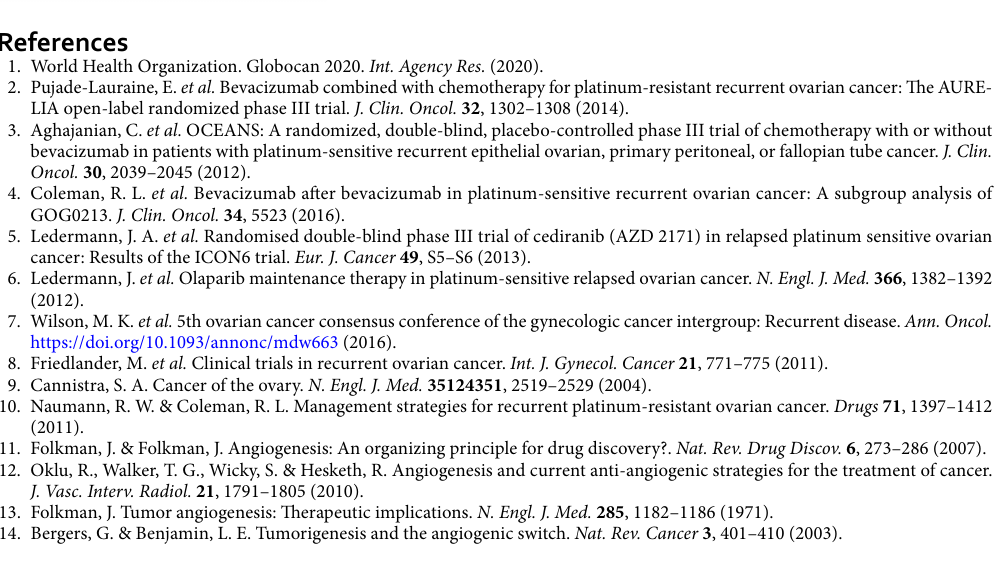
Figure 5. ( a ) Network plot of comparisons among different anti-angiogenic agents and standard of care chemotherapy for overall survival in the platinum-sensitive setting. Key for ( a ): Bev_C Bevacizumab (concurrent), Bev_CM Bevacizumab (concurrent + maintenance), Ced_CM Cediranib (concurrent + maintenance), Chemo Standard of care chemotherapy. Note for ( a ): Nodes represent the interventions, lines connecting nodes represent direct comparisons between pairs of interventions, the number stated on the lines represents the number of studies involved in the comparisons. ( b ) Comparative effectiveness of different anti-angiogenic agents and standard of care chemotherapy for overall survival in the platinum-sensitive setting. Key for ( b ): Bev_C Bevacizumab (concurrent), Bev_CM Bevacizumab (concurrent + maintenance), Ced_CM Cediranib (concurrent + maintenance); Chemo, Standard of care chemotherapy. Note for ( b ): The upper triangle of the matrix displays only the pooled effect sizes of the direct comparisons available in the network. Fields that remain empty in the upper triangle mean that the direct evidence for the comparison is not available. The lower triangle shows the estimated effect sizes for each comparison even when only indirect evidence is available. In the lower triangle of the matrix, values in each cell represent the hazard ratio (HR and 95% confidence interval) of the intervention at the top, compared to the comparator on the left. When HR < 1, prefers the column intervention, indicating that the column intervention is more effective than the row intervention on reducing overall survival. When HR > 1, prefers the row intervention. Significant results are in bold and underlined for both upper and lower triangles. ( c ) Network plot of comparisons among different anti-angiogenic agents and standard of care chemotherapy for progression-free survival in the platinum-sensitive setting. Key for ( c ): Bev_C Bevacizumab (concurrent), Bev_CM Bevacizumab (concurrent + maintenance), Ced_CM Cediranib (concurrent + maintenance), Chemo Standard of care chemotherapy. Note for ( c ): Nodes represent the interventions, lines connecting nodes represent direct comparisons between pairs of interventions, the number stated on the lines represents the number of studies involved in the comparisons. ( d ) Comparative effectiveness of different anti-angiogenic agents and standard of care chemotherapy for progression-free survival in the platinum-sensitive setting. Key for ( d ): Bev_C Bevacizumab (concurrent), Bev_CM Bevacizumab (concurrent + maintenance), Ced_CM Cediranib (concurrent + maintenance); Chemo, Standard of care chemotherapy. Note for ( d ): The upper triangle of the matrix displays only the pooled effect sizes of the direct comparisons available in the network. Fields that remain empty in the upper triangle mean that the direct evidence for the comparison is not available. The lower triangle shows the estimated effect sizes for each comparison even when only indirect evidence is available. In the lower triangle of the matrix, values in each cell represent the hazard ratio (HR and 95% confidence interval) of the intervention at the top, compared to the comparator on the left. When HR < 1, prefers the column intervention, indicating that the column intervention is more effective than the row intervention on reducing overall survival. When HR > 1, prefers the row intervention. Significant results are in bold and underlined for both upper and lower triangles. ( e ) Comparative effectiveness of different anti-angiogenic agents and standard of care chemotherapy in platinum-sensitive setting: P-scores for overall survival. Key for ( e ): Bev_C Bevacizumab (concurrent), Bev_CM Bevacizumab (concurrent + maintenance), Ced_CM Cediranib (concurrent + maintenance), Chemo Standard of care chemotherapy. Notes for ( e ): The higher the P-scores, the higher likelihood that an intervention is in the top rank or one of the top ranks. ( f ) Comparative effectiveness of different anti-angiogenic agents and standard of care chemotherapy in platinum- sensitive setting: P-scores for progression-free survival. Key for ( f ): Bev_C Bevacizumab (concurrent), Bev_CM Bevacizumab (concurrent + maintenance), Ced_CM Cediranib (concurrent + maintenance); Chemo, Standard of care chemotherapy. Notes for ( f ): The higher the P-scores, the higher likelihood that an intervention is in the top rank or one of the top